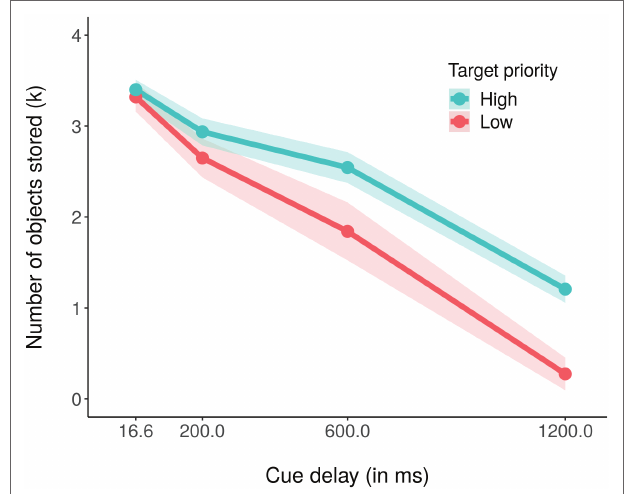
FIGURE 3 | Mean number of estimated stored objects in visual working memory ( k ) in the high (blue coded) and low (red coded) priority conditions for the four cue delays. The shaded area around each line stands for the standard error of the means.